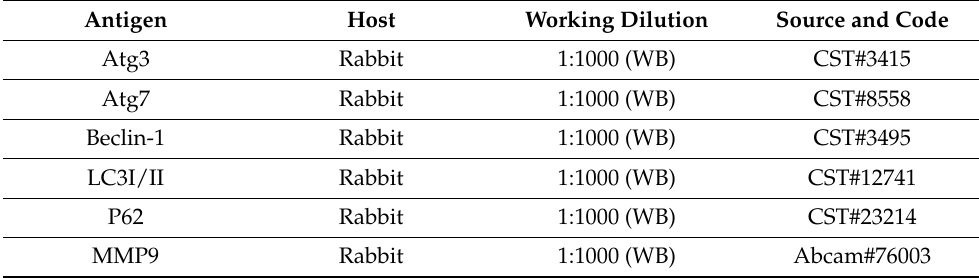
Table 1. Antibodies Used in this